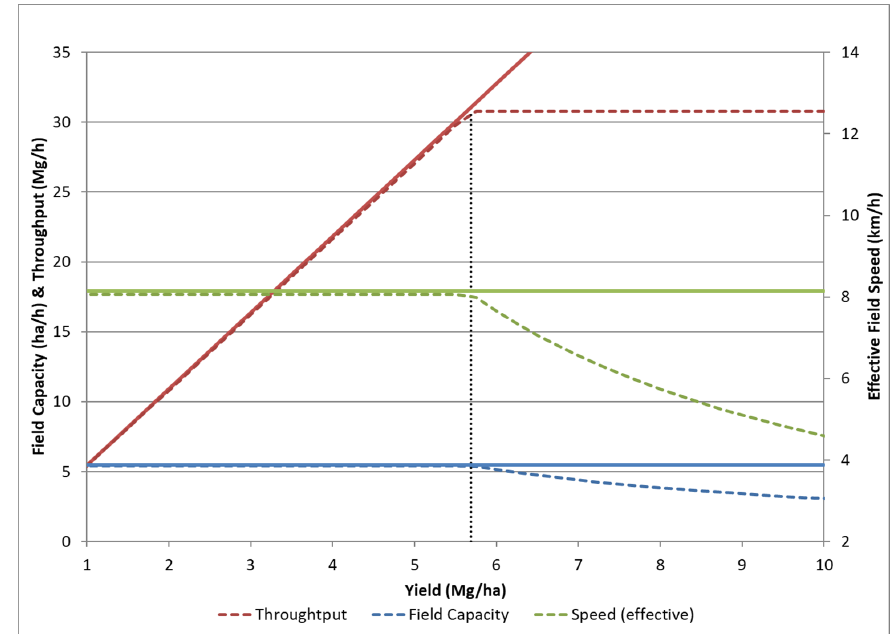
Figure 2. The impact of maximum throughput, showing how achieved field capacity and speed decrease as yield increases. Equations (1), (2), and (4) are used and assumed operating conditions are: W = 6.7 m, v = 10.9 km/h, E f = 0.74, C mx = 30.8 Mg/h, Y c = 5.6 Mg/ha. Most machines will not reach maximum throughput in convention forage harvesting.